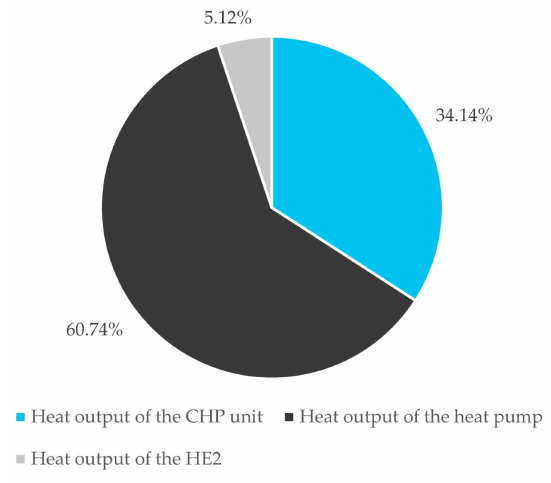
Figure 5. Distribution of the heat output of the